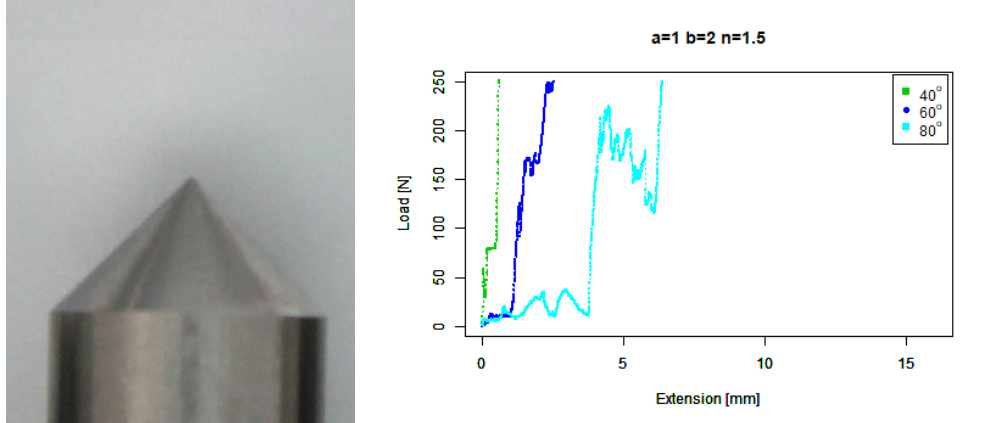
Figure 9. Basic angled tip. ( Left ) Tip Profile. ( Right ) Experimental characterisation.